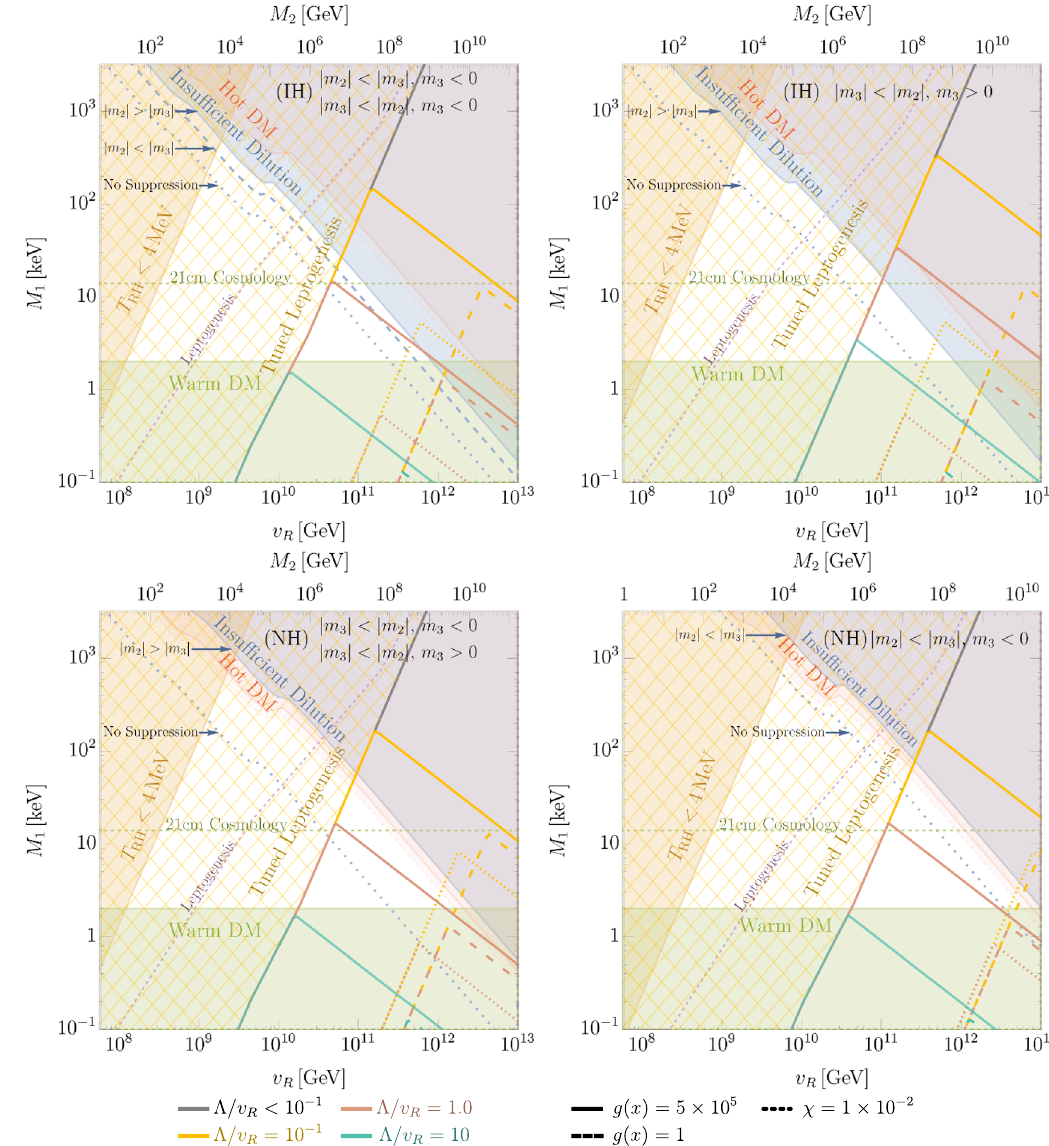
Figure 14 . The parameter space where frozen-out N 1 DM and N 2 leptogenesis can naturally be realized without radiative corrections affecting the stability of N 1 DM and in accord with the active neutrino mass spectrum. The shaded (unhatched) regions solely constrain N 1 DM from freeze-out as in figure 2. The hatched gold region indicates where the baryon asymmetry generated by N 2 is unable to match the observed baryon asymmetry with g ( x ) set to its largest, natural value, and y 33 set by consistent neutrino masses. The right, downward sloping contours mark where the radiative corrections to y i 1 are sufficiently large that they must be unnaturally tuned with tree contributions to keep N 1 DM stable when g ( x ) is set to its largest, natural value, and y 33 set by consistent neutrino masses for Λ /v R = 0 . 1 , 1 , 10 ( gold , red , green ). The dashed and dotted contours show the same region when M 2 and M 3 are comparable, ( g ( x ) = 1 , dashed) and m ( ss ) and m (5) are as naturally 3 3 degenerate as can be ( g ( x ) at χ min , dotted). Naturalness and neutrino mass consistency excludes areas with too low or high values of v R , and places a strong upper bound on the cutoff Λ . We fix the ν 2 and ν 3 masses by the Inverted Hierarchy (IH, Top ) and Normal Hierarchy (NH, Bottom